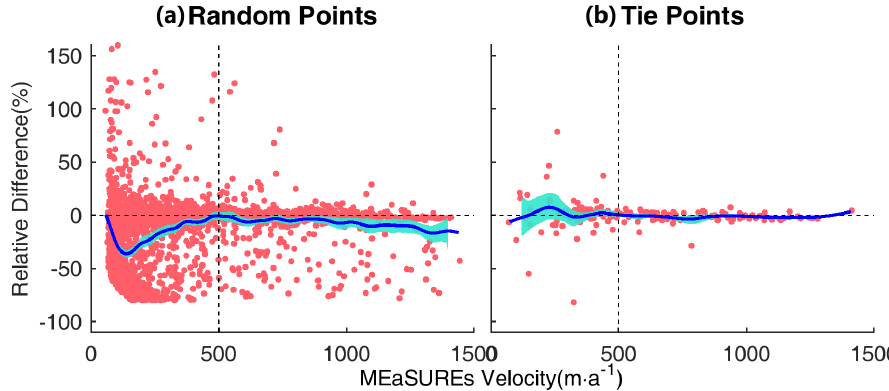
Figure 7. Relative difference with respect to MEaSUREs in ( a ) 3000 randomly strewn points and ( b ) 178 manually selected tie points. The blue margins represent 95% confidence interval, and vertical dash lines represent 500 m · a − 1